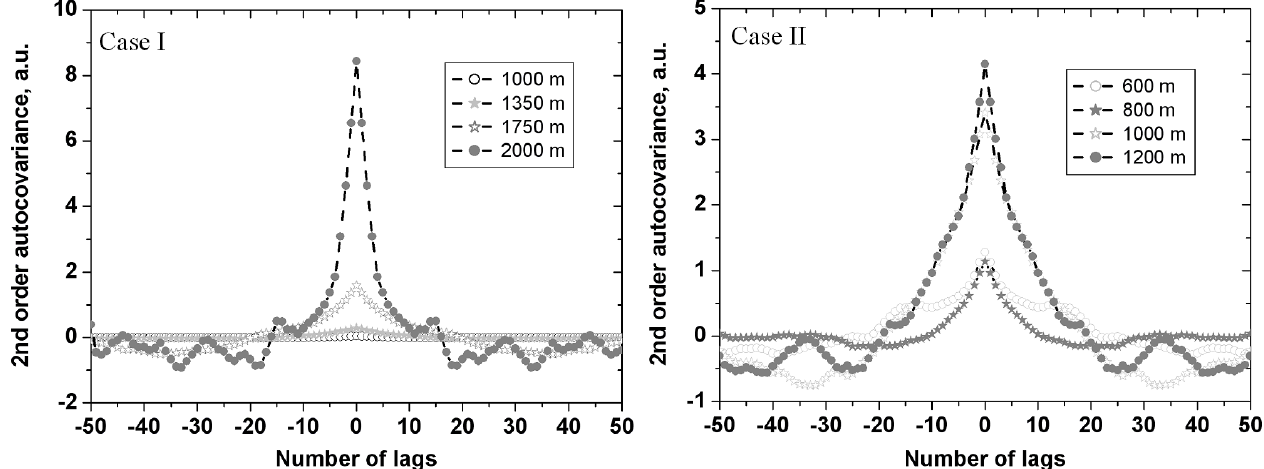
Fig. 10. Second-order autocovariance functions for four different heights for case I (left) and case II (right). The inertial range is resolved by only 5–7 data points. One lag corresponds to a shift of 10s of the time series in the autocovariance function.